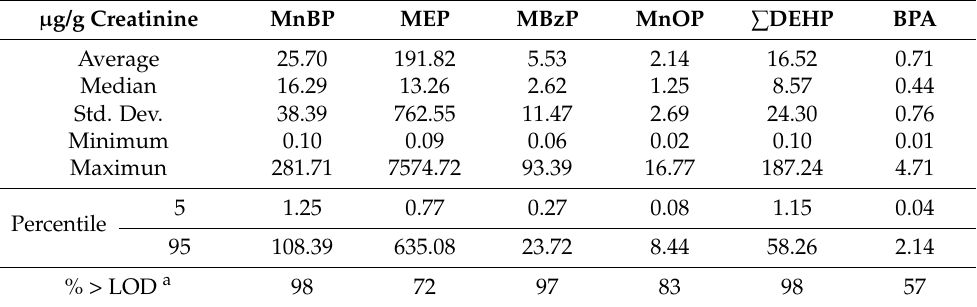
Table 5. Results of urinary phthalate and BPA assays.